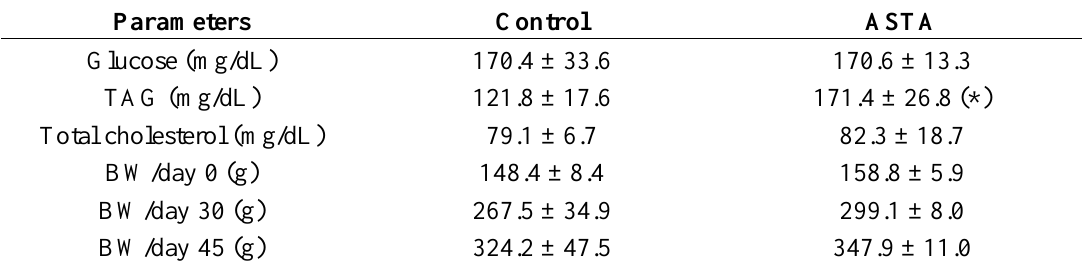
Table 1. Glucose, triacylglycerol (TAG), and cholesterol concentrations in plasma and body weight of Wistar rats supplemented for 45 days with 1 mg ASTA/kg body weight (BW). * ( p < 0.05).